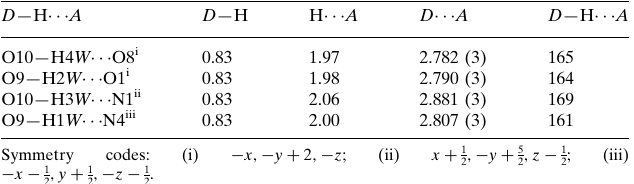
Hydrogen-bond geometry (A˚ , (cid:2)